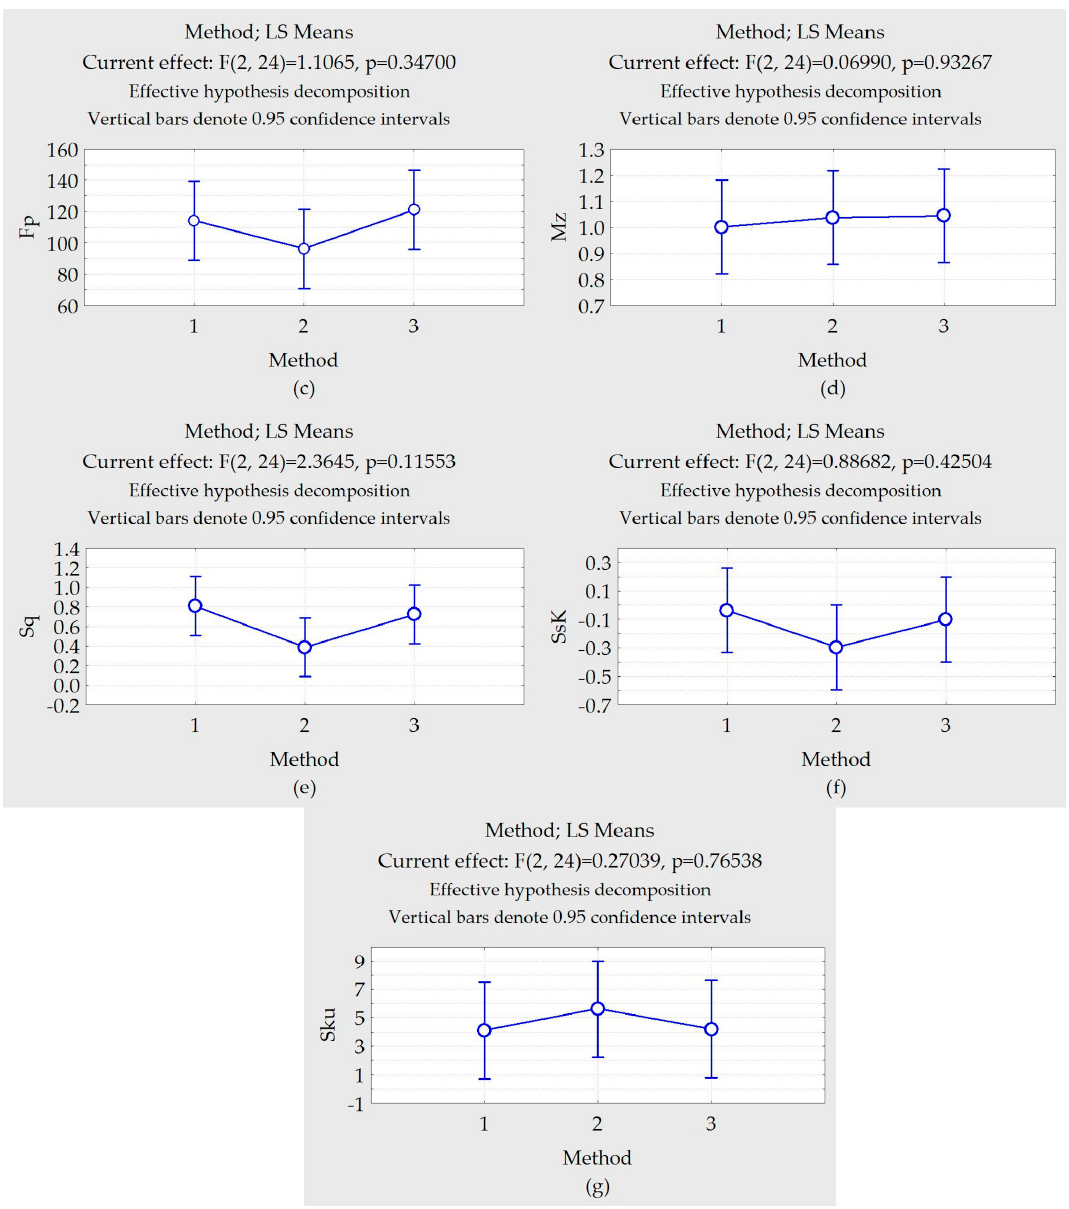
Figure 22. Differences between pairs of averages. ( a ) Cutting force F c ( b ) Feed force F f . ( c ) Penetration Force F p . ( d ) Torque M z . ( e ) Roughness S q . ( f ) Skewness. ( g ) Kurtosis.